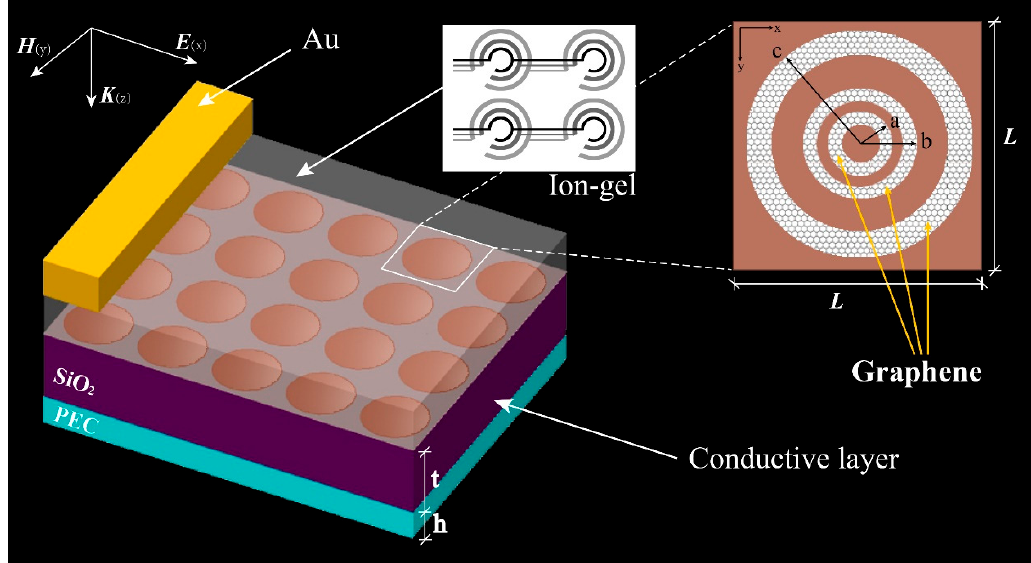
Figure 1. Schematic of the proposed broadband metamaterial-based perfect absorber (MPA)consisting of the graphene concentric triple ring (GCTR) and the perfect electrical conductor (PEC) mirror separated by a thin SiO 2 spacer. The ion-gel was spin-coated on the graphene nanostructures and contacted to the Au electrodes as the top gate. Also, an ultra-thin and transparent conduct thin layer was deposited between the SiO 2 and graphene as the bottom gate. The geometrical parameters of the proposed MPA are t = 28 μ m and L = 11 μ m. The outer radii of three rings are a = 1.5 μ m, b = 2.5 μ m , c = 4.5 μ m, the widths of three rings are 0.2 μ m, 0.5 μ m, 1.1 μ m.